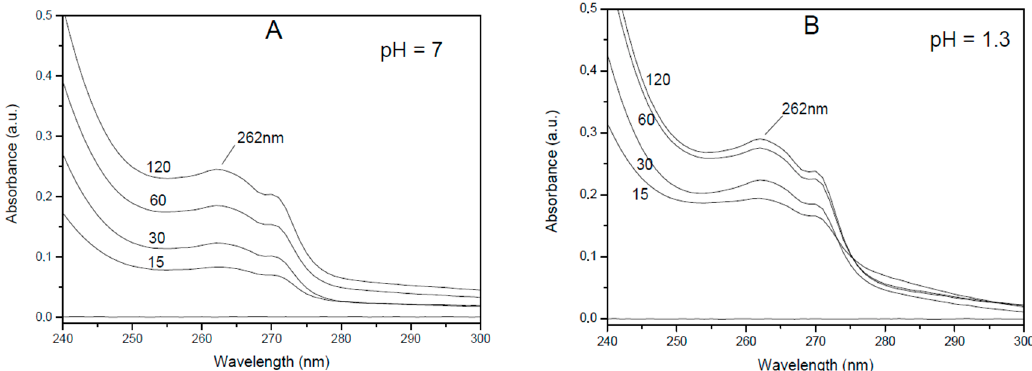
Figure 4. UV spectra in the 240 − 300 nm range of aqueous solutions, after different soaking times (from 15 min up to 120 min) of the lidocaine adduct with oxidized charcoal: ( A ) neutral saline solution; ( B ) acidic (pH = 1.3) solution.